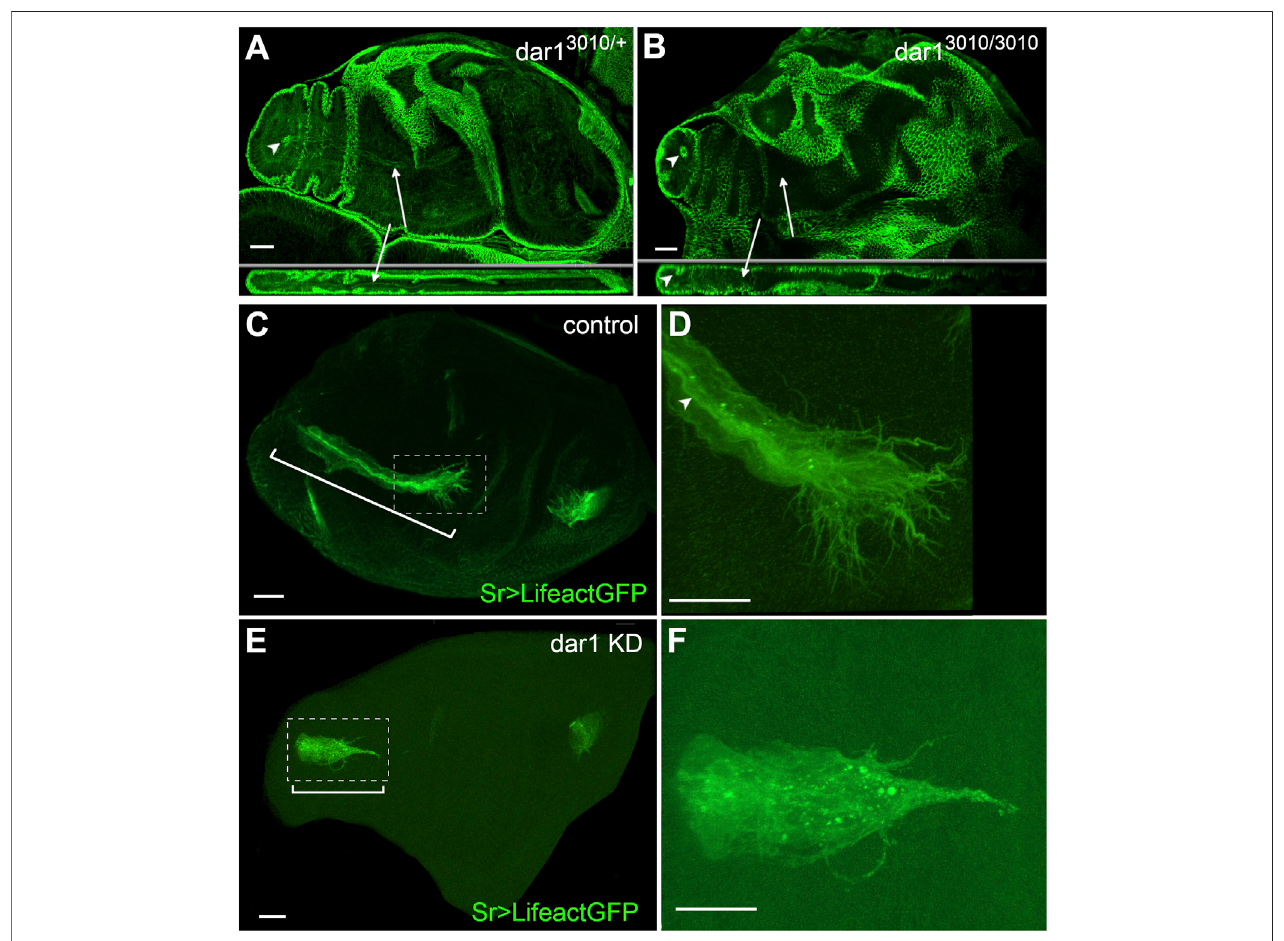
FIGURE5| Dar1isnotrequiredfortheepitheliuminvaginationbutisneededforactin-rich fi lopodiaarborizationoflongtendons (A,B) Confocalsectionsof2 hAPF leg discs immunostained with anti-dlg (A) selected optical sections of control dar1 3010/+ heterozygous leg disc. dlg accumulation reveals lumen aperture on the most distal tarsal segment (arrowhead) and also stained a long internal structure corresponding to tarsal lt (arrow) (B) In all observed leg discs from rare dar1 3010/3010 homozygous mutant escapers, local constriction of the epithelium still underlines the local invagination of the epithelial cells, but no elongating internal structure is formed (arrows) (number of samples, control dar1 3010/+ n (cid:2) 10, dar 3010/3010 n (cid:2) 5) (C – F) Confocal sections of 0 h APF leg discs from sr-gal4,dar1 3010/+ > UAS- Lifeact.GFP and sr-gal4,dar1 3010/+ > UAS-Lifeact.GFP,UAS-dar1RNAi 2 h APF pupae. On these selected optical sections, in dar1 KD condition tarsal lt (bracket in E) appears much shorter than in the control (bracket in C) (D) and (F) are higher magni fi cations from (C) and (E) respectively (D) In the control leg disc, leading cells at the distal part of the elongating tendon display numerous actin-rich protrusions at their basal membrane and apical accumulation of actin underlines the tube lumen (arrowhead) (F) Inthe dar1 KDlegdisc, fi lopodiaarborizationissystematicallyaffectedwithamarkeddecreaseinprotrusionnumber(numberofsamples,control n (cid:2) 10, dar1 KD n (cid:2) 17). Overall Lifeact.GFP distribution is strongly affected and tube lumen cannot be distinguished in dar1 KD. Scale bar 20 μ m.